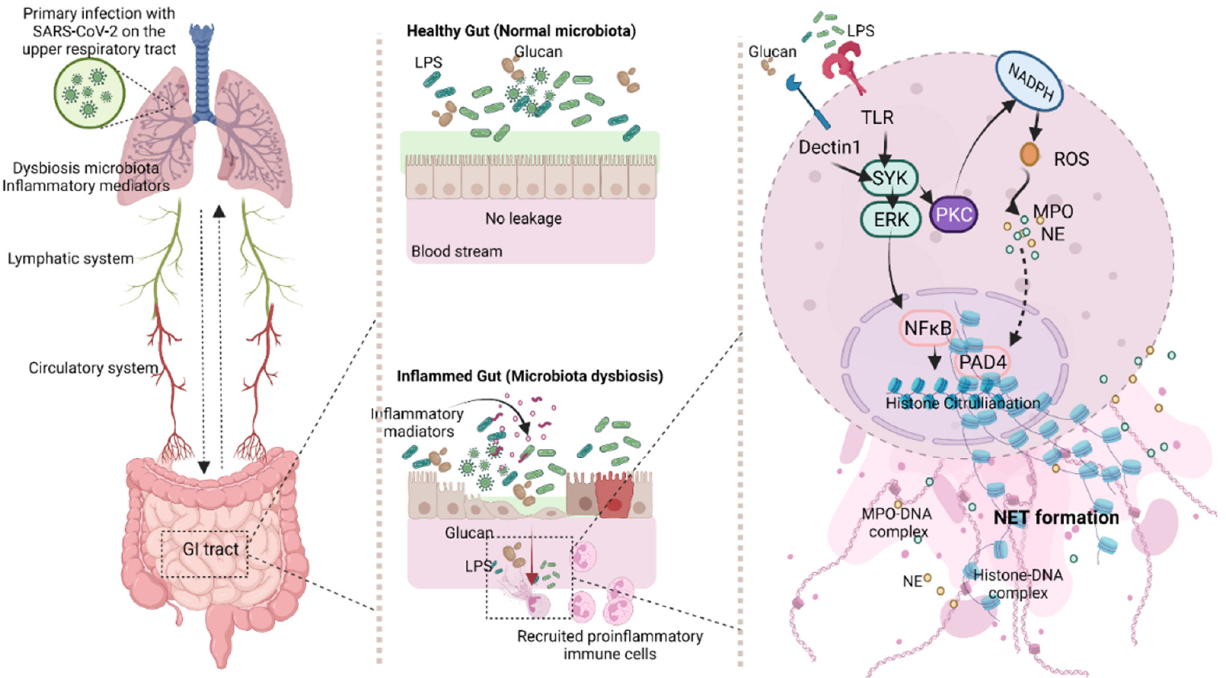
Figure 7. The working hypothesis proposes a mechanism of gut barrier defect and neutrophil extracellular traps (NETs) in SARS-CoV-2 infection that originates from the lung before infecting other ACE-2 positive cells, including enterocytes. Cytokine storm and enterocyte damage enable the gut translocation of pathogen molecules, lipopolysaccharide (LPS), and (1 → 3)- β -D-glucan (BG), that possibly enhance neutrophil responses through TLR-4 and Dectin-1, respectively, with downstream signaling, spleen tyrosine kinase (SYK), extracellular-signal-regulated kinases (ERK), protein kinase C (PKC), nuclear factor kappa B (NF κ B), and nicotinamide adenine dinucleotide phosphate (NADH). These mediators finally activate NETs-associated molecules, peptidylarginine deiminase 4 ( PAD-4 ), myeloperoxidase (MPO), and neutrophil elastase (NE). Gut barrier defect, cytokine storm, and neutrophilia in COVID-19 infection elevate systemic inflammatory responses and sepsis severity. ROS—reactive oxygen species.